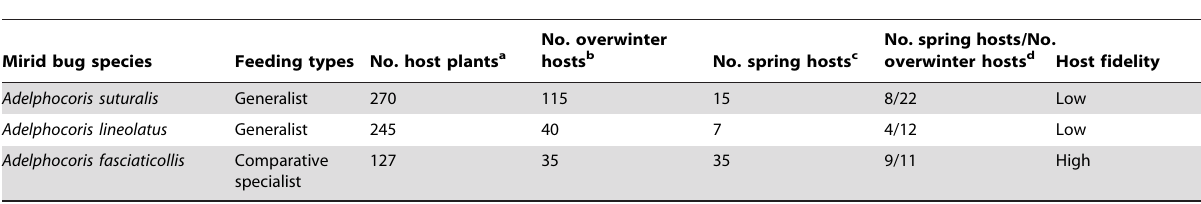
Table 3. Host fidelity of Adelphocoris spp. between the winter and the spring.